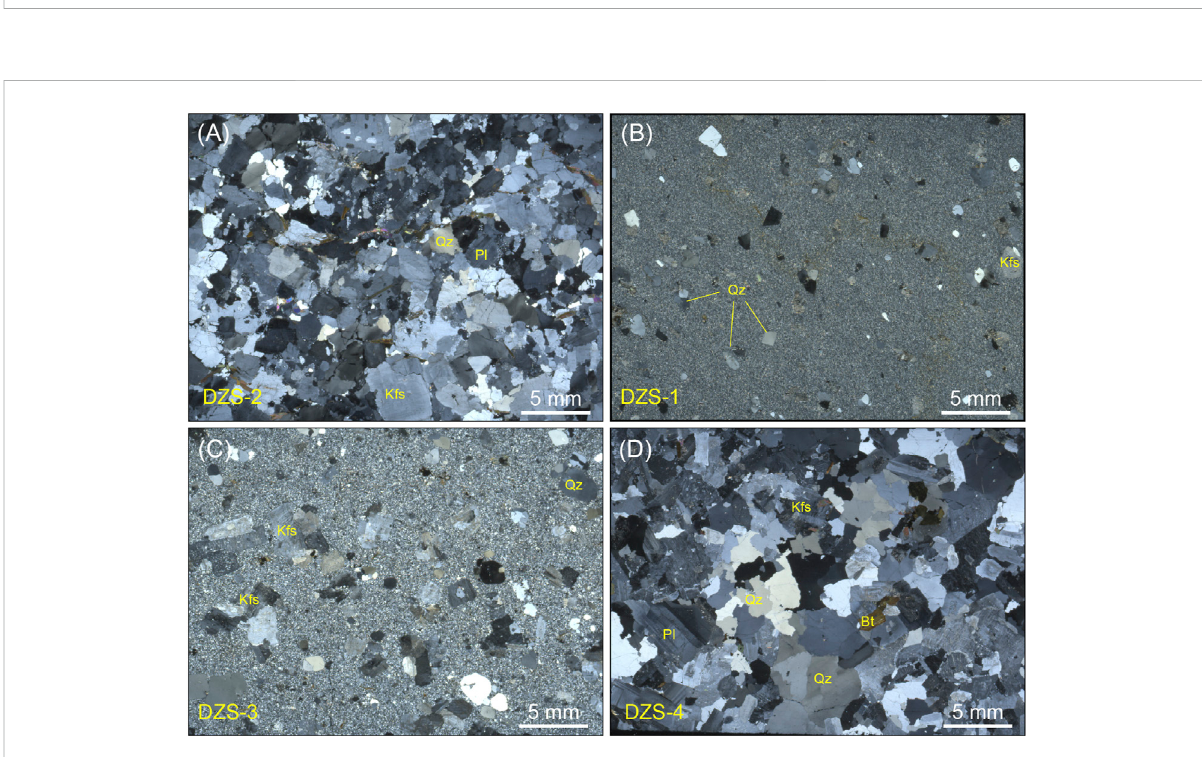
FIGURE 3 Microscopic images of Linglong granite (A) , quartz porphyry (B) , rhyolite porphyry (C), and Dazeshan biotite granite (D) . Abbreviations: Kfs = K-feldspar, Pl = plagioclase, Qz = quartz, Bt = biotite. The abbreviations for the minerals are after Whitney and Evans.